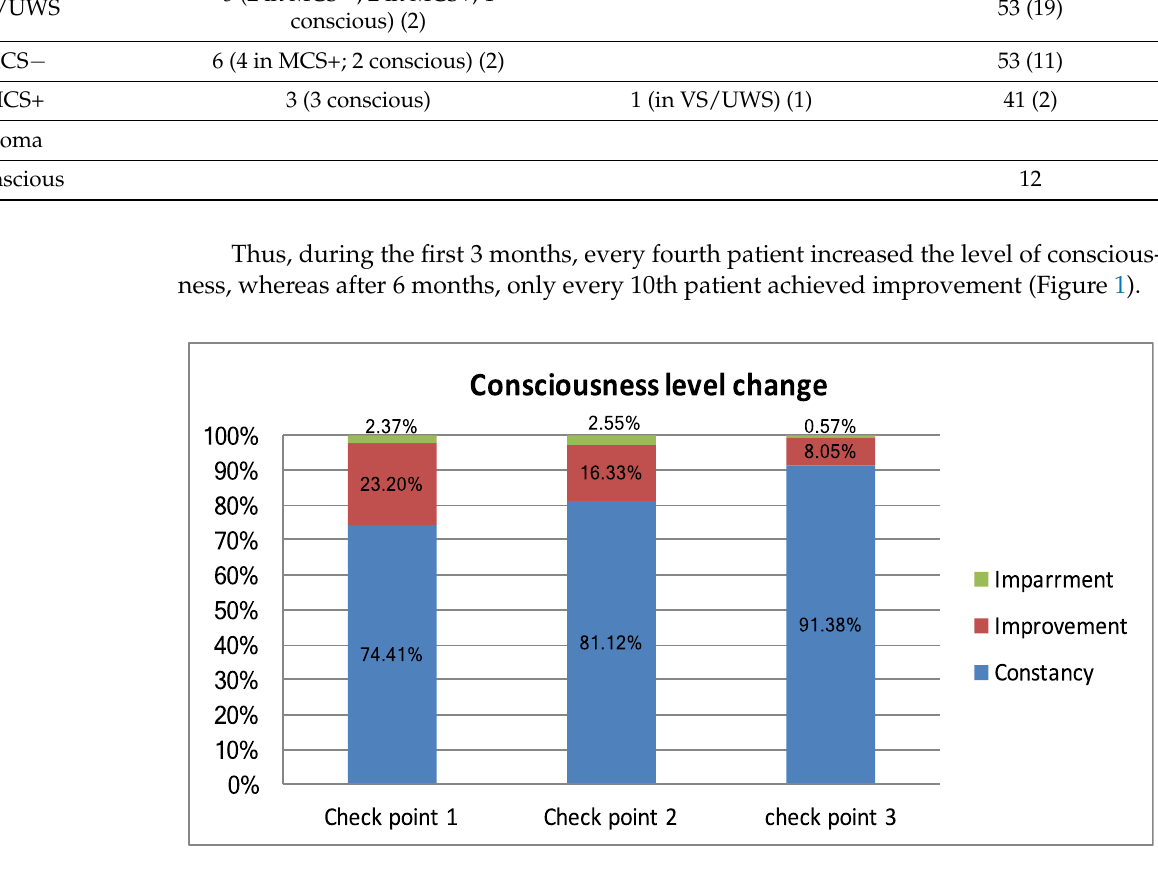
Figure 1. Histogram representation of changes in the level of consciousness at three control points.